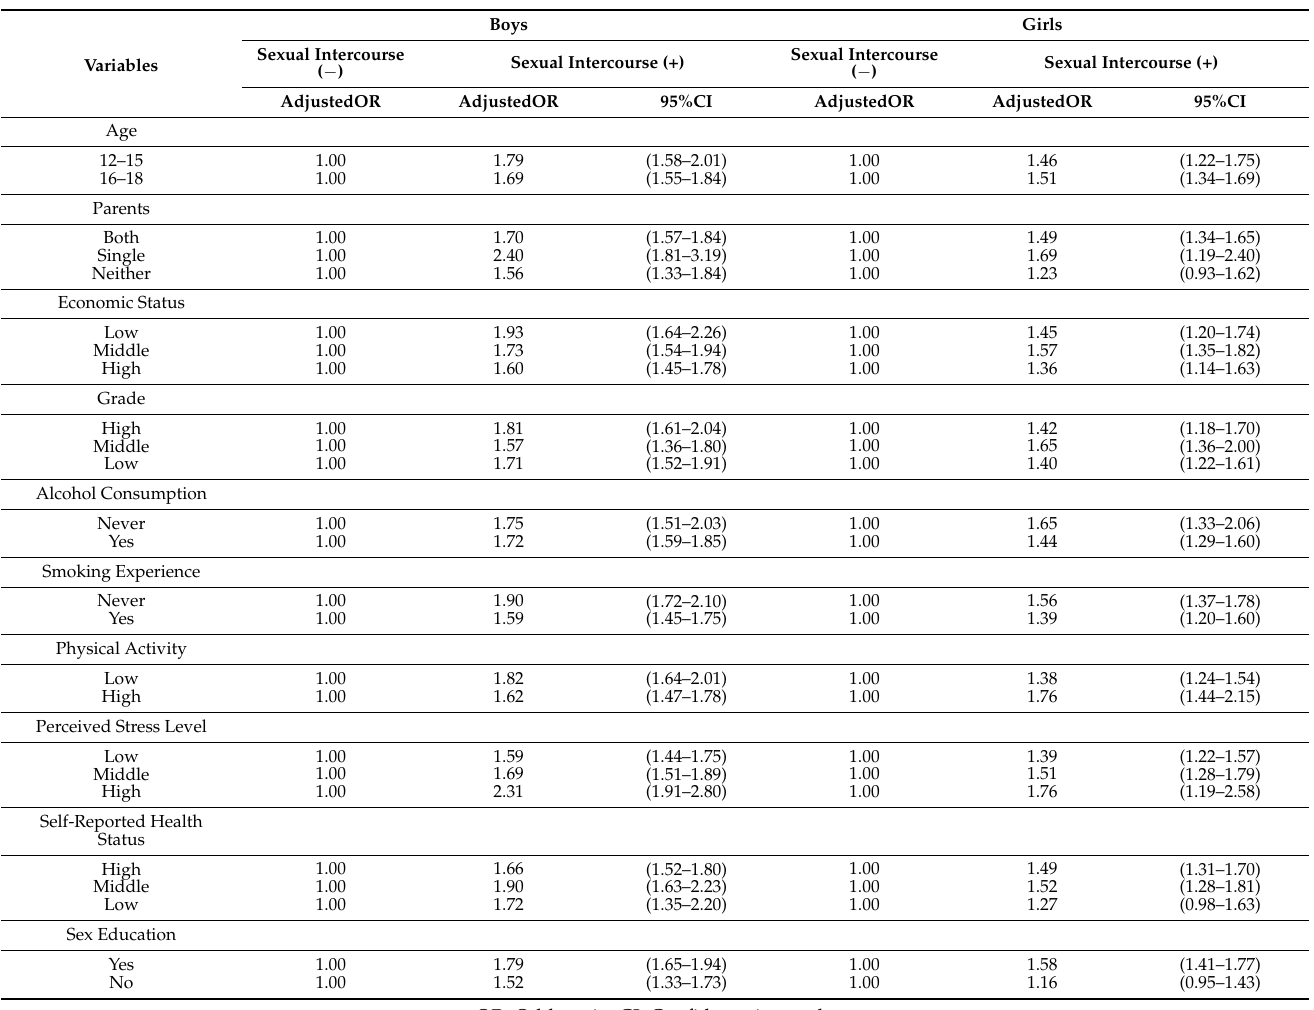
Table 3. Subgroup analysis of the association between sexual behavior and depression stratified by sociodemographic variables.